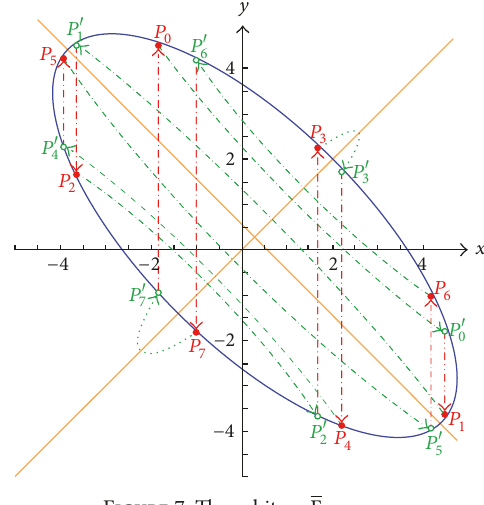
Figure 7: The orbit on Γ 1,√2,4,4√2